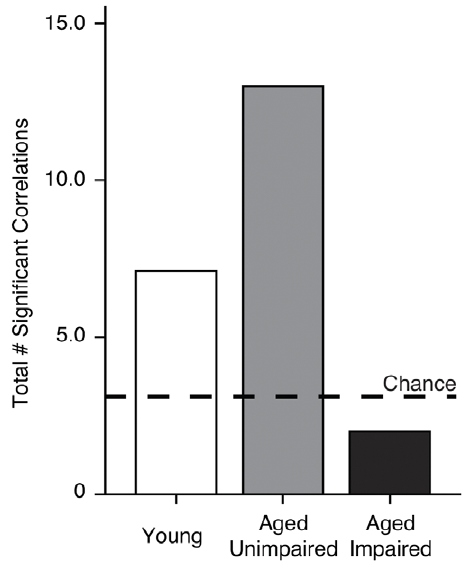
Figure 4. Total number of significant epigenetic/spatial memory correlations for Y, AU, and AI rats. Summary of results from Table 1, illustrating the number of statistically significant correlation coefficients observed between the epigenetic marks examined and learning index scores from the standard spatial version of the water maze. Only correlations computed for the Y, AU and AI groups considered separately were included, i.e., cases where sample size and within-group variance was similar. Chance reflects from the number of correlation coefficients computed per group (i.e., 63), and the nominal alpha value (i.e., 0.05). The number of significant correlations exceeded chance selectively for Y and AU groups.